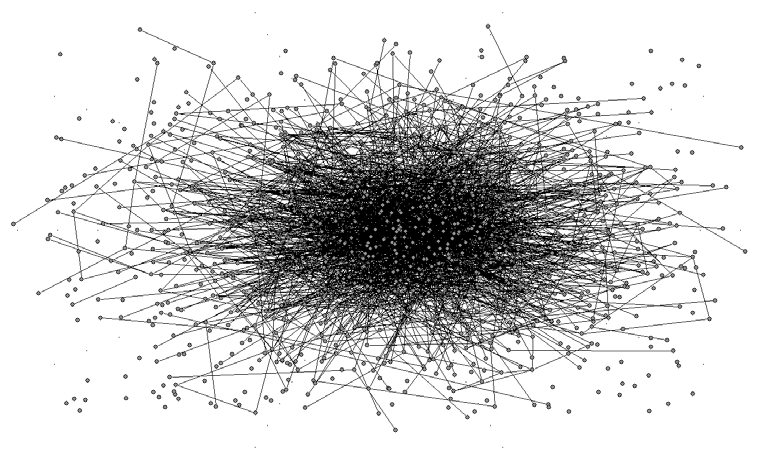
Fig. 4. Co-authorship network in convergence